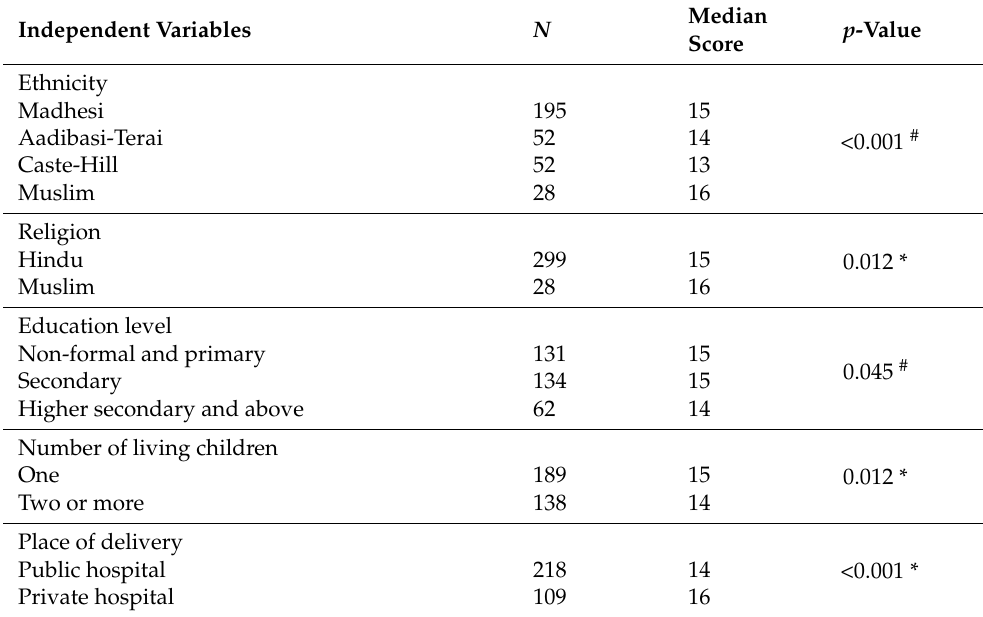
Table 4. Factors associated with disrespect and abuse of women during childbirth ( N = 327). Independent Variables